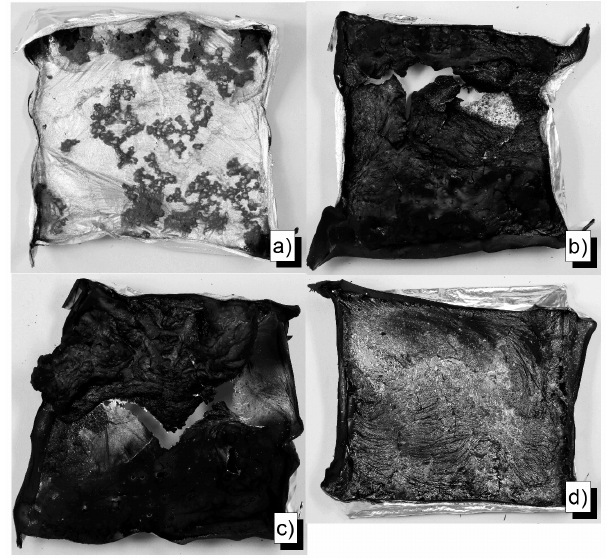
Figure 13. Residue pictures: Pes ( a ); Pes-15-ExOP935 ( b ); Pes-15-ExOP1230 ( c ); and Pes-25-BDP ( d ).